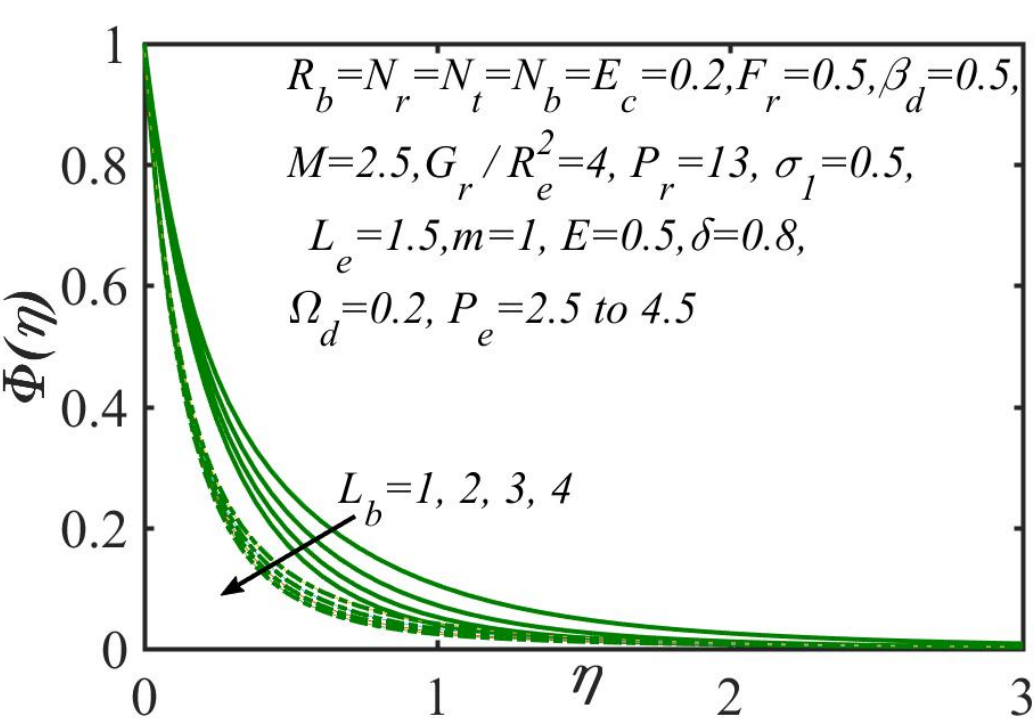
Figure 13. Variation in δ and E on concentration distribution. Solid line: E = 0.5, Dotted line: E = 2.0.